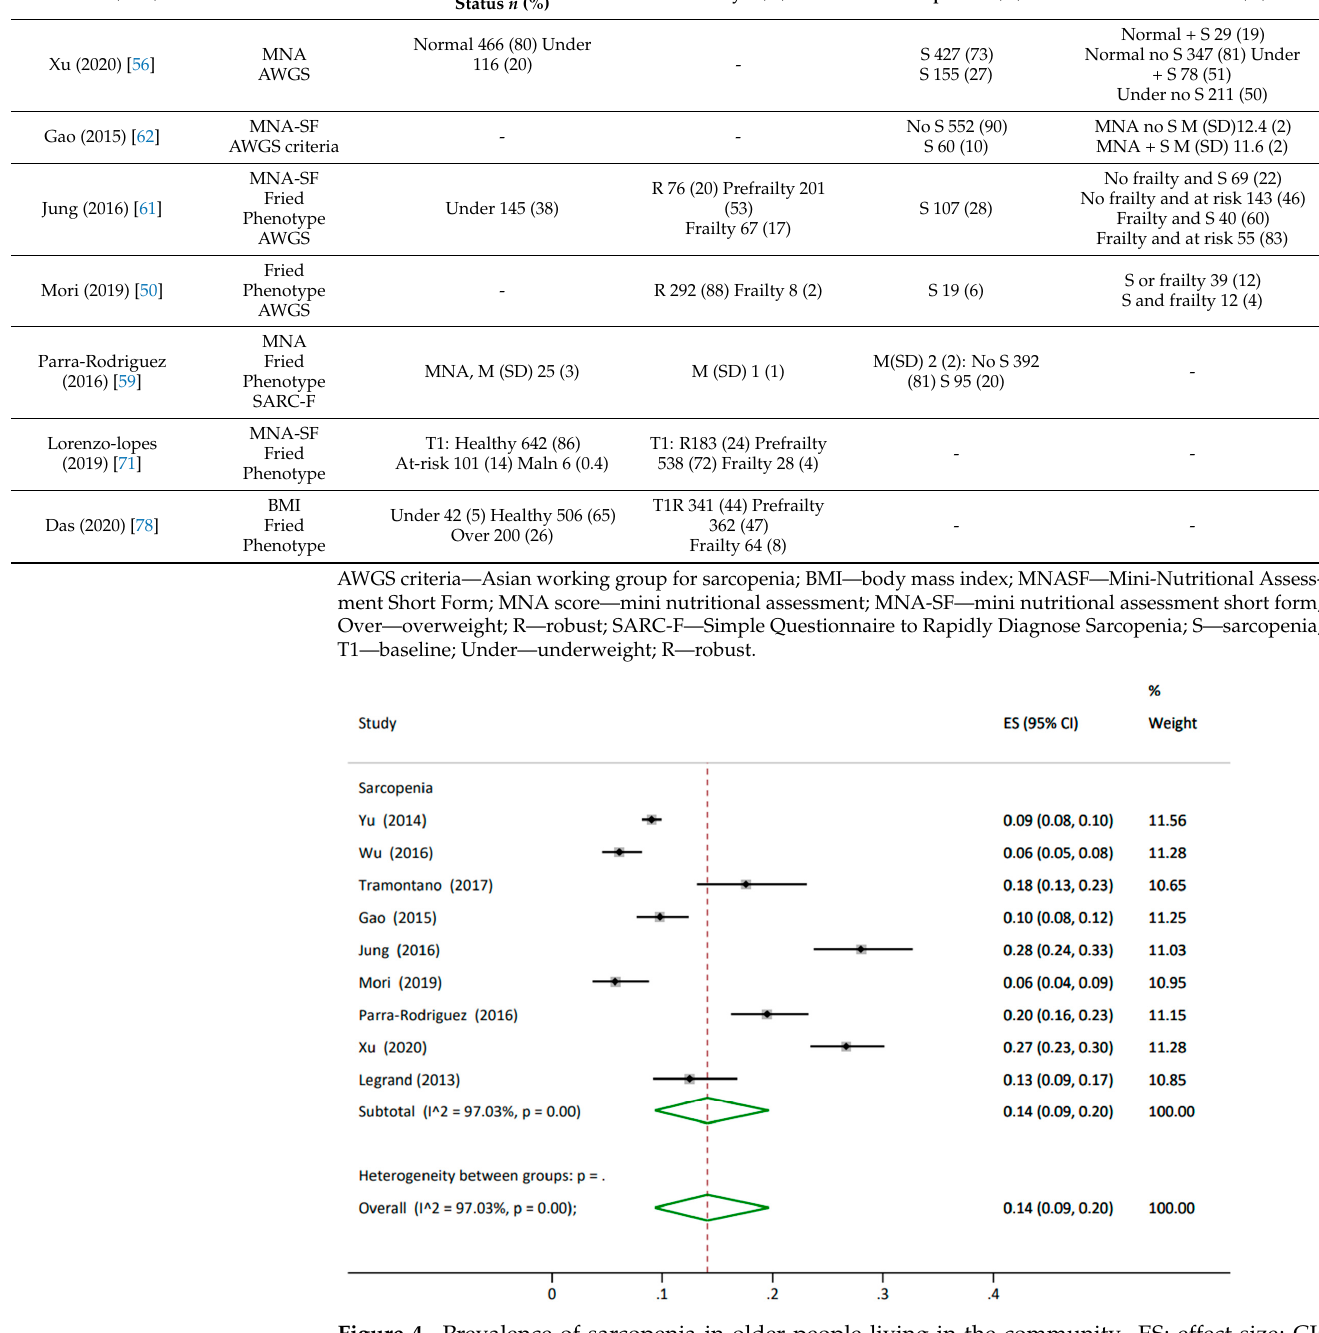
Figure 4. Prevalence of sarcopenia in older people living in the community. ES: effect size; CI: confidence interval.